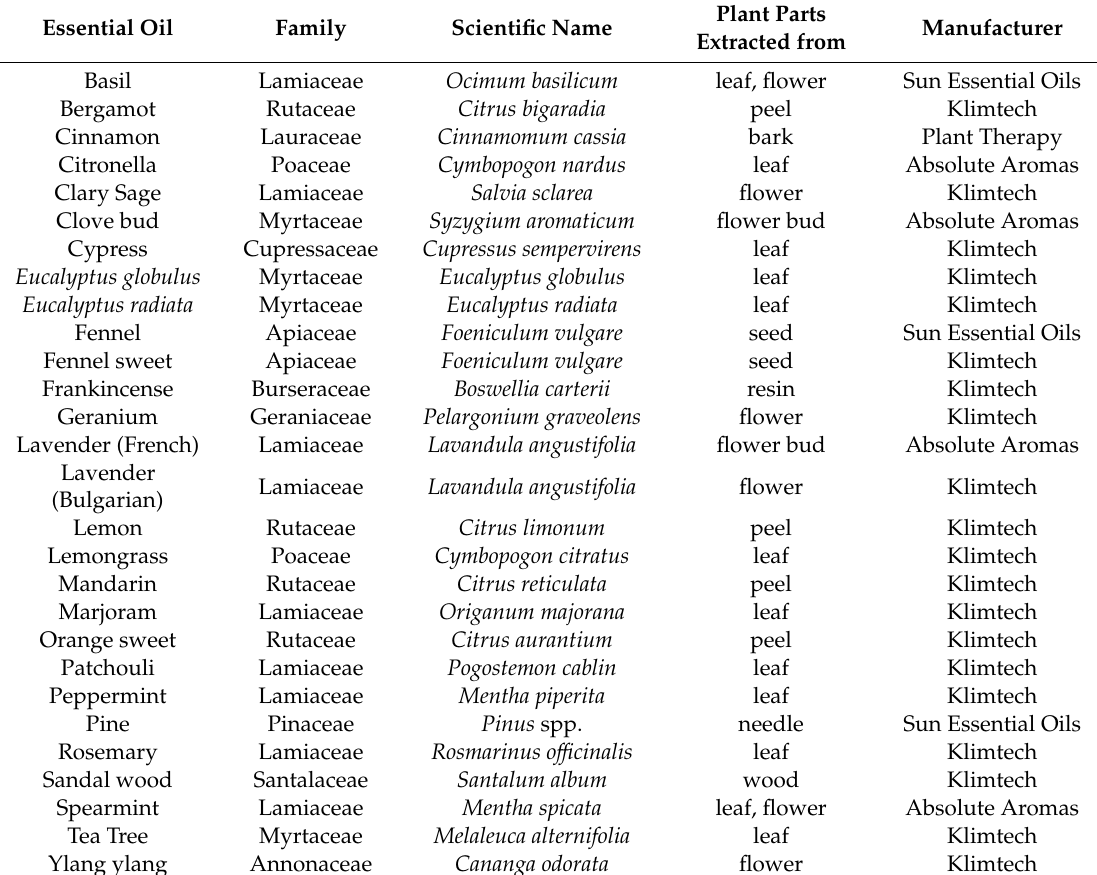
Table 1. Plant species and essential oils tested in this